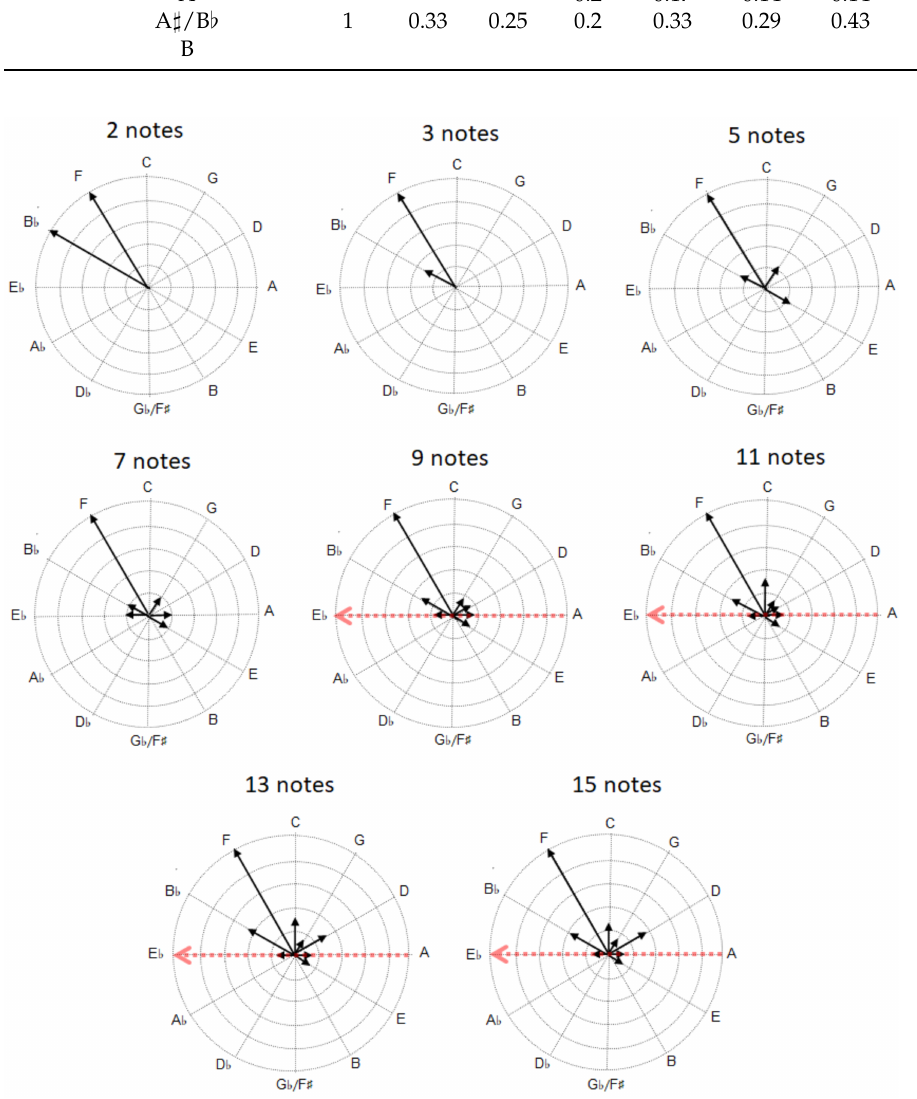
Figure 13. Music signatures corresponding to the fragment of the composition presented in Figure 12, obtained for 2, 3, 5, 7, 9, 11, 13, and 15 notes; the red arrow represents the main directed